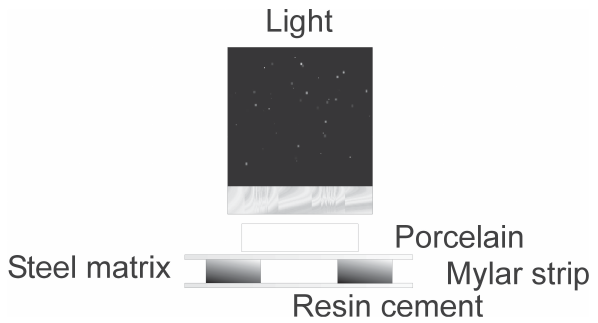
FIGURE 1- Diagram of the experimental set-up used for polymerization of resin cement through ceramic TABLE 2- Vickers Hardness numbers (VHN) and standard deviations (SD) of Enforce dual-cured cement